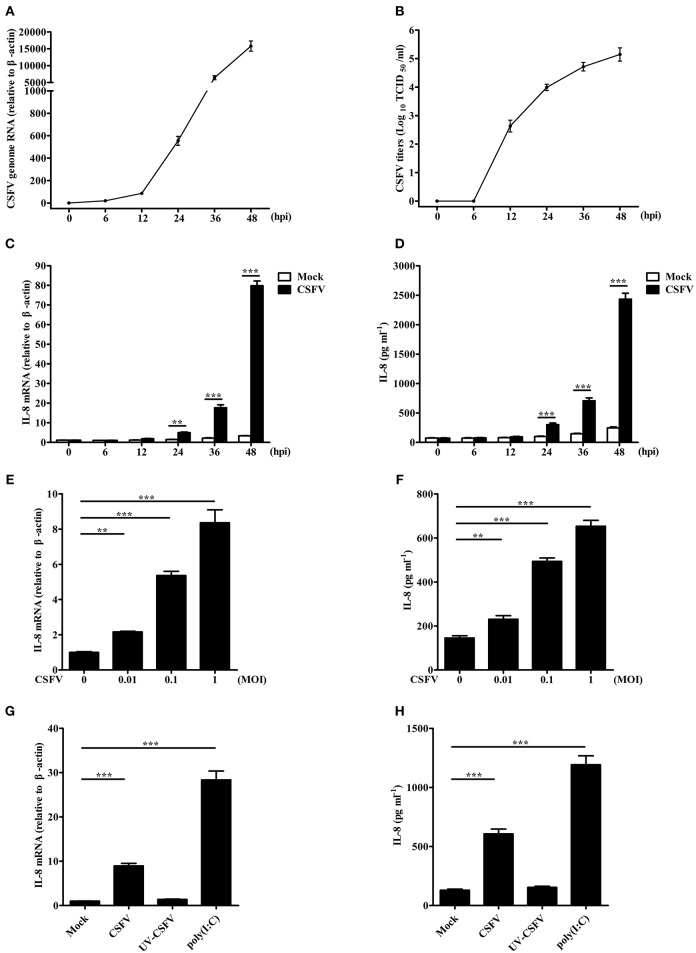
CSFV infection induces IL-8 production. (A,B) The growth curve of CSFV. SUVECs were infected with CSFV at an MOI of 1. The supernatants, which contain progeny viruses, and cells were collected at 0, 6, 12, 24, 36, and 48 hpi, respectively. CSFV genome RNA was determined by real-time PCR. The extracellular viral titers were detected and expressed as TCID50/mL. The supernatants at 0 hpi was the supernatants of SUVECs infected without CSFV at 0 h. (C–F) IL-8 mRNA expression and secretion in CSFV-infected SUVECs. SUVECs were infected with CSFV at an MOI of 1 and IL-8 mRNA expression and secretion were determined at 0, 6, 12, 24, 36, and 48 hpi (C,D), or infected at an MOI of 0, 0.01, 0.1, and 1 and IL-8 mRNA expression and secretion was determined at 36 hpi (E,F) by real-time PCR and ELISA. (G,H) IL-8 mRNA expression and secretion in UV-inactivated CSFV-infected SUVECs. SUVECs were infected with CSFV or UV-inactivated CSFV at an MOI of 1 for 36 h or were transfected with poly(I:C) (1 μg/mL) for 12 h and analyzed for IL-8 production by real-time PCR and ELISA. Error bars represent the mean ± SD (n = 3). **P < 0.01; ***P < 0.001.